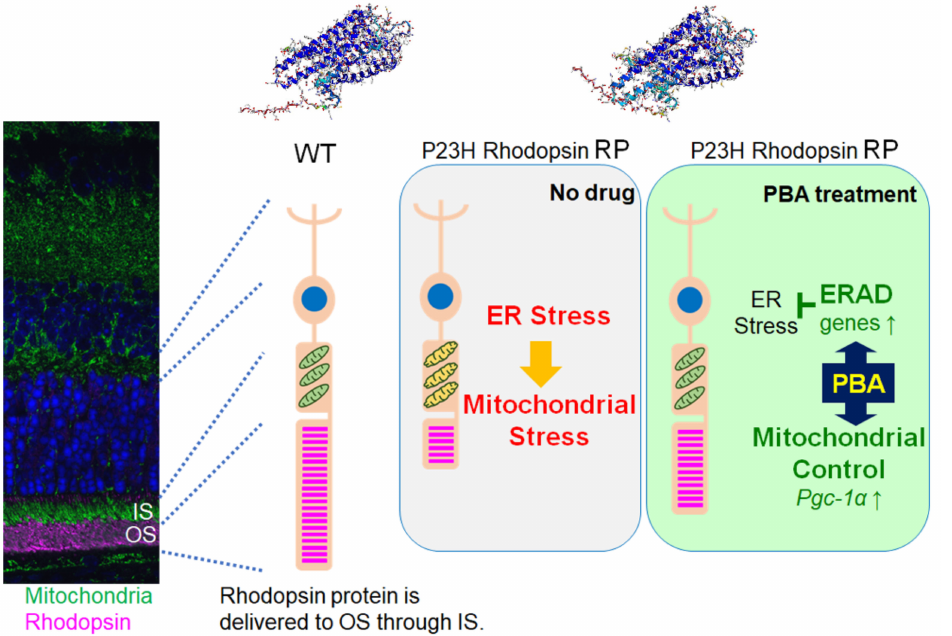
Figure 7. Proposed roles of PBA in photoreceptor neuroprotection and visual protection P23H rhodopsin mutant protein causes misfolding and ER stress, and may have damaged mitochondria, thus weaken photoreceptors and impaired visual function. In contrast, constant PBA administration induced ERAD, and moreover, pgc-1 α most likely through epigenetic change and may have affected mitochondrial quality control leading to supply ATP required to run the ERAD system, which protected photoreceptors and visual function. Protein structures (alphafold2; https://alphafold.ebi. ac.uk/ (accessed 14 February 2022) are shown at the top (left, wild-type rhodopsin; right, P23H mutant rhodopsin). IS, inner segment (where ER and mitochondria are densely distributed); OS, outer segment (where rhodopsin is